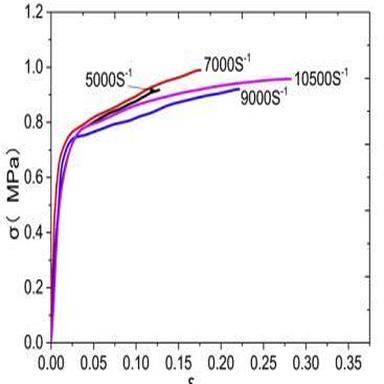
Stress-strain curves under different conditions.